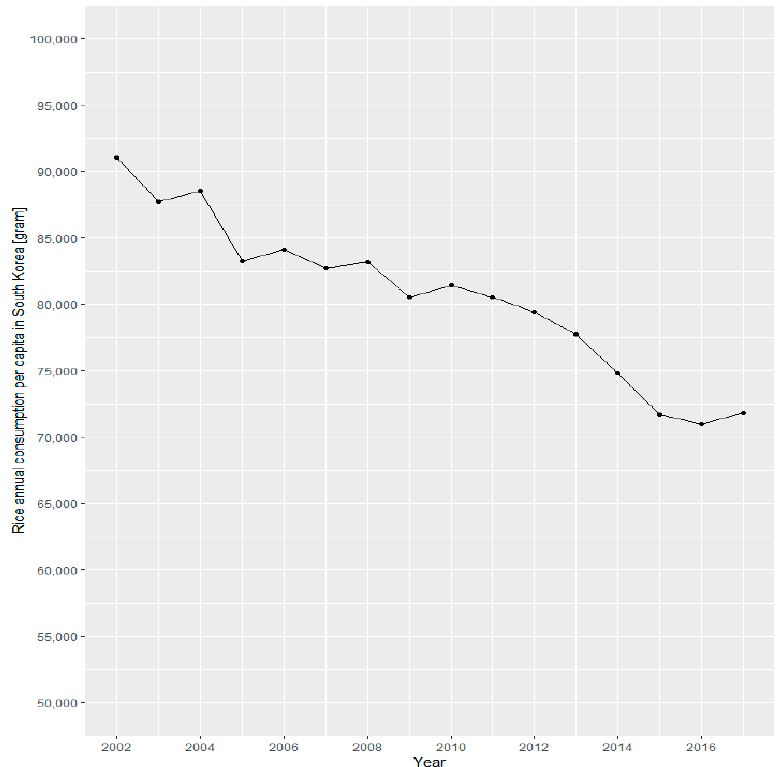
Figure A5. Trend of rice consumption per capita (unit: gram); Source: Korea Rural Economy Institute [50]; 2017 Food Balance Sheet.